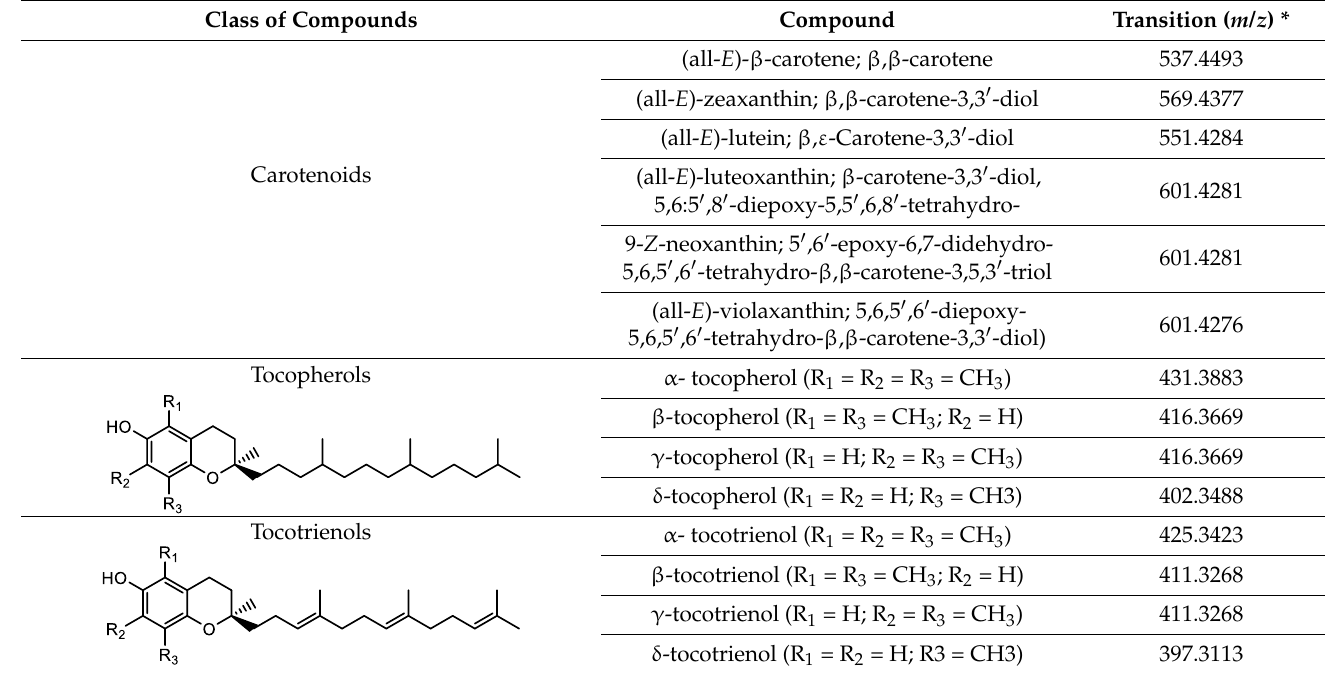
Table 2. The selected ion monitoring (SIM) transitions ( m/z ) utilized for carotenoid and tocol analysis. Class of Compounds